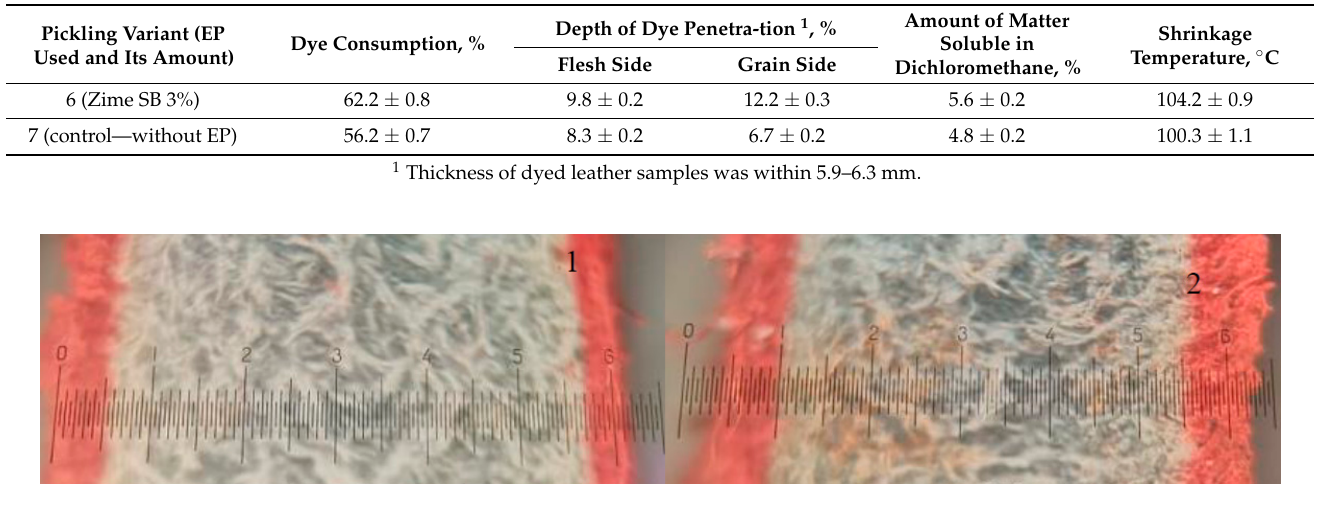
Figure 4. Images of dyed leather cross-section: magnification 15 times. 1 —pickled conventionally; 2 —pickled adding EP Zime SB 3%.